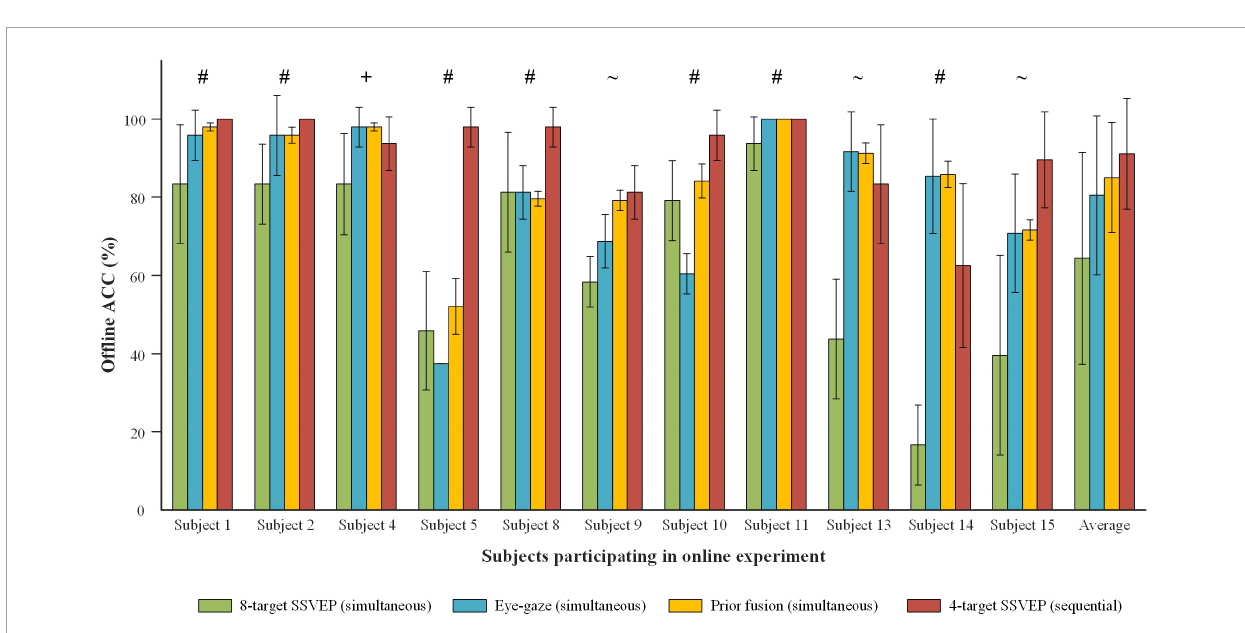
FIGURE12 ACC comparison of 8-target SSVEP, eye-gaze and prior fusion in offline simultaneous mode and that of 4-target SSVEP in offline sequential mode at online stimulus duration for each subject who participated in online experiment. Subjects’ preference modes are expressed at the top of the bars, where ‘+’ indicates the simultaneous mode, ‘#’ indicates the sequential mode, and ‘ ∼ ’ indicates no